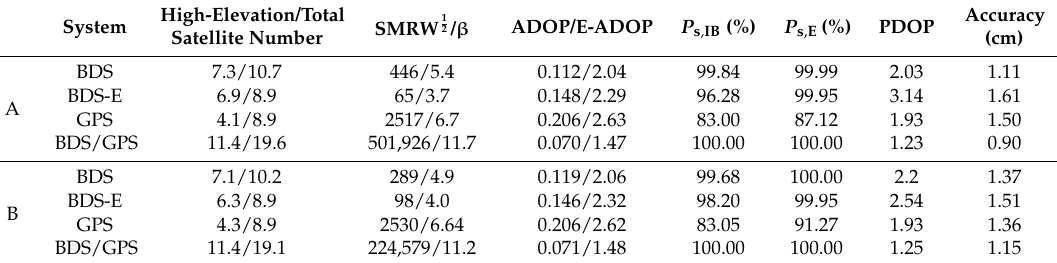
Table 3. Results of BDS, BDS-E, GPS and BDS/GPS for 5 km baseline.